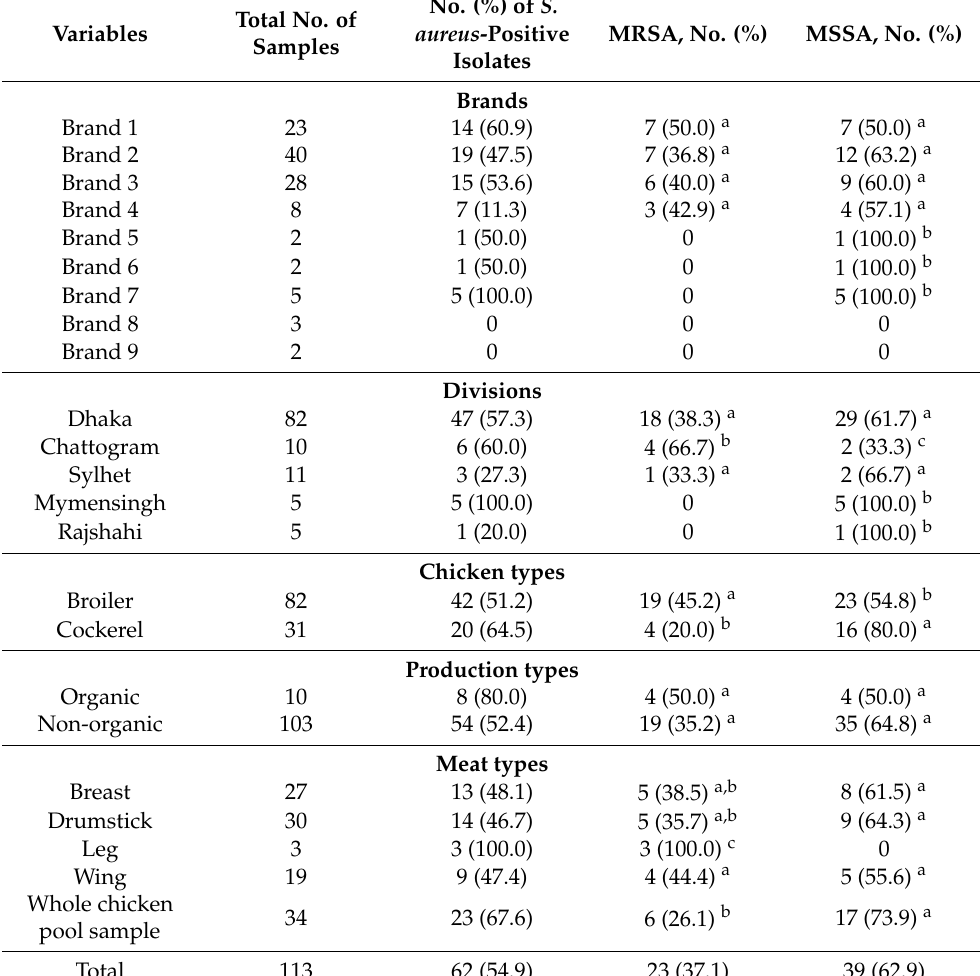
Table 1. Prevalence and distribution of MRSA and MSSA isolated from frozen chicken meat.